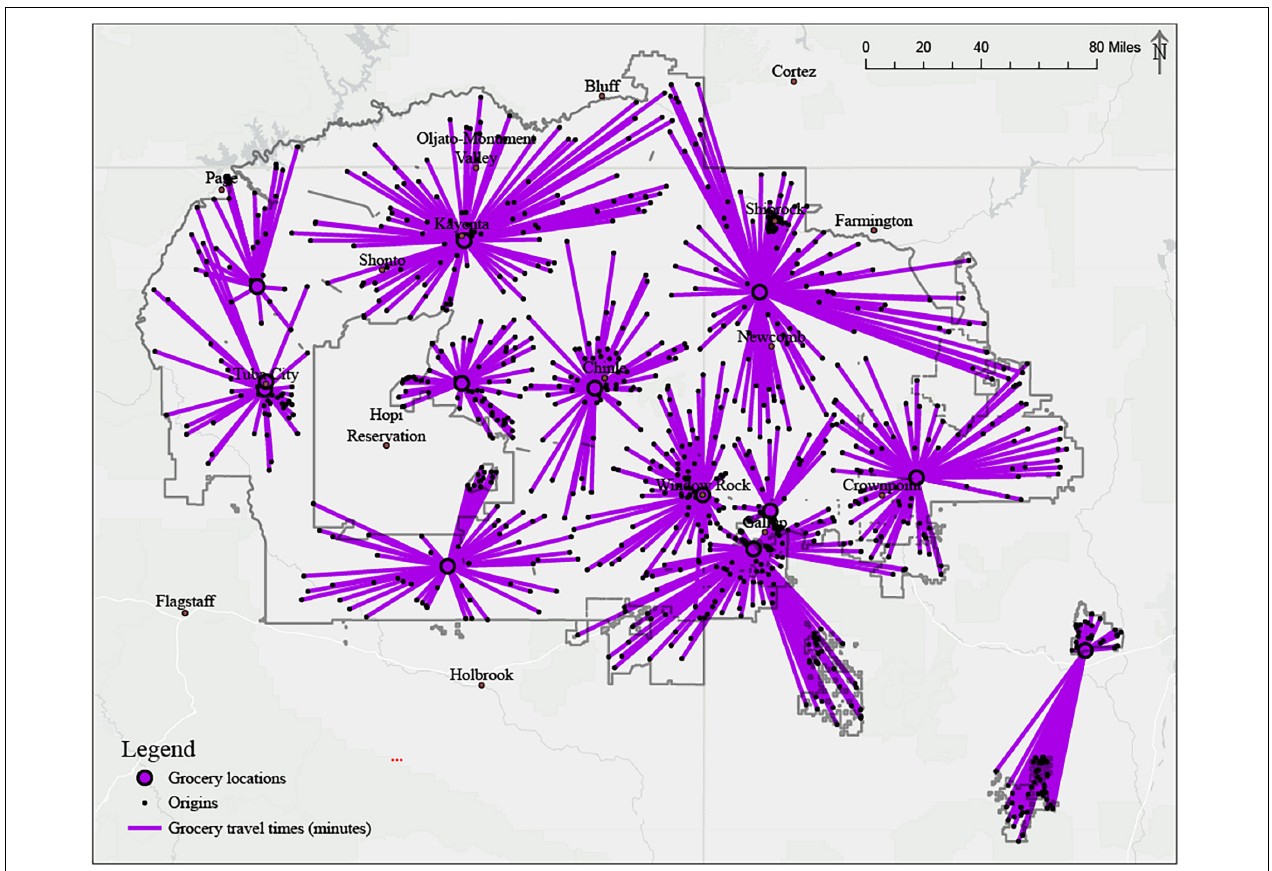
FIGURE 2 | Origin-cost destination matrix tool; Grocery stores within the Navajo